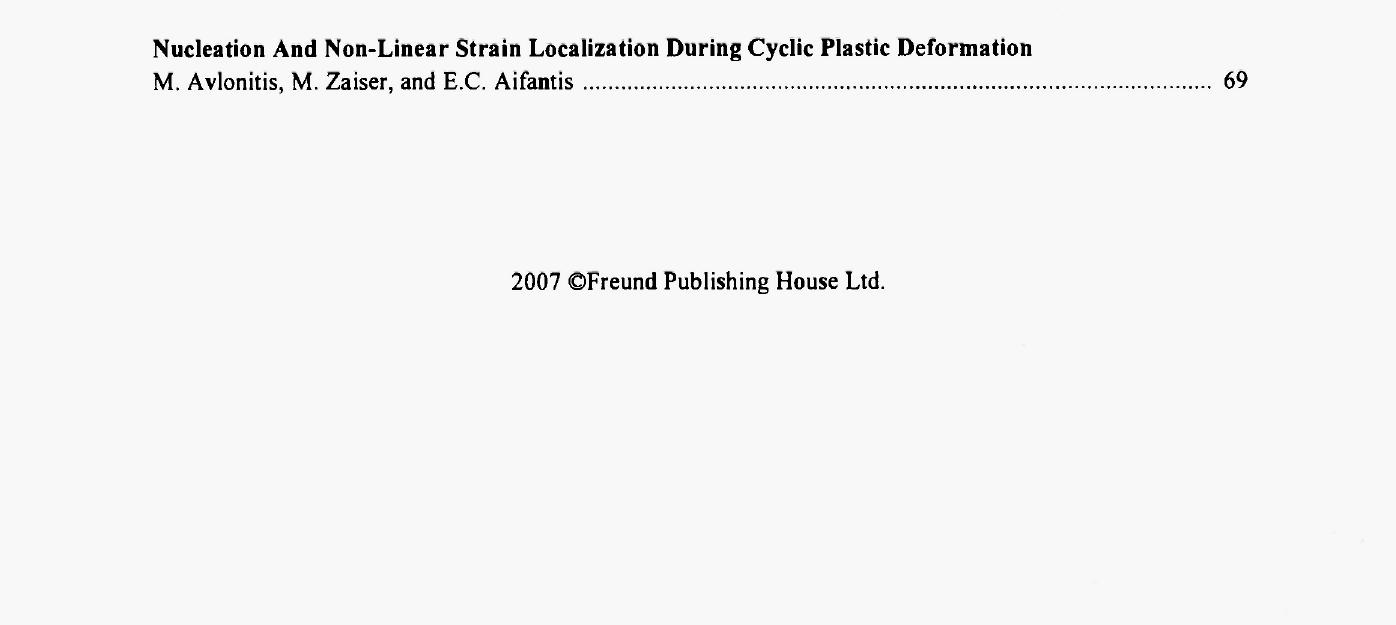
On the Historical Role of Aristotelian